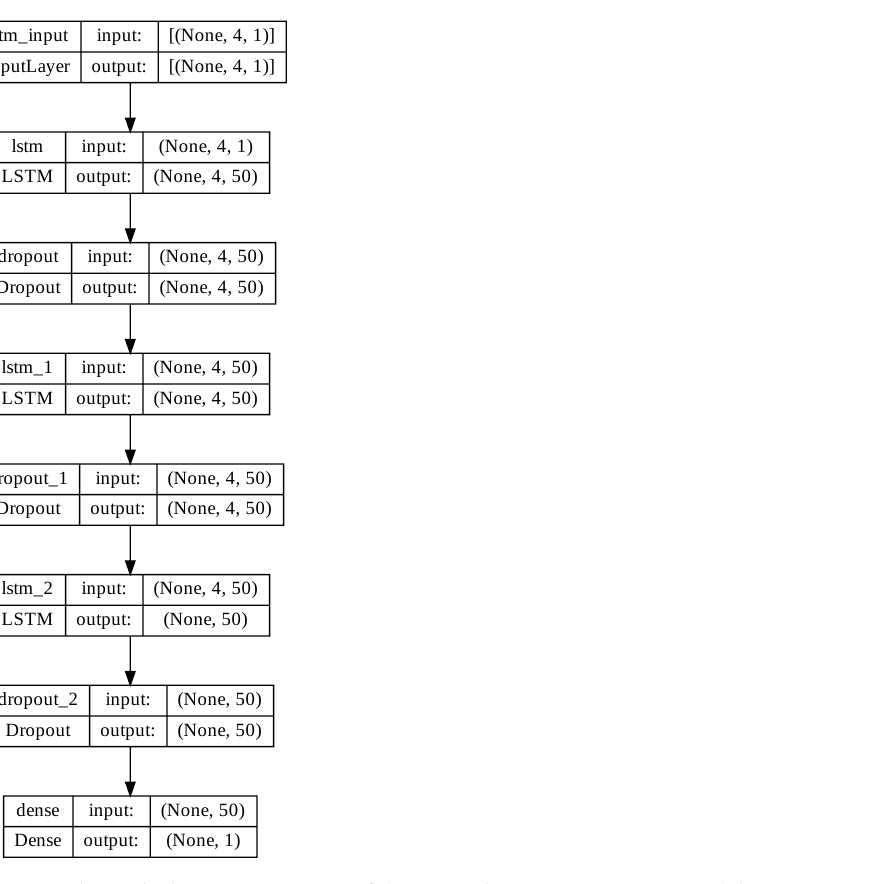
The mean square error is the average of the absolute difference between the expected value and the result of a given trial (6).